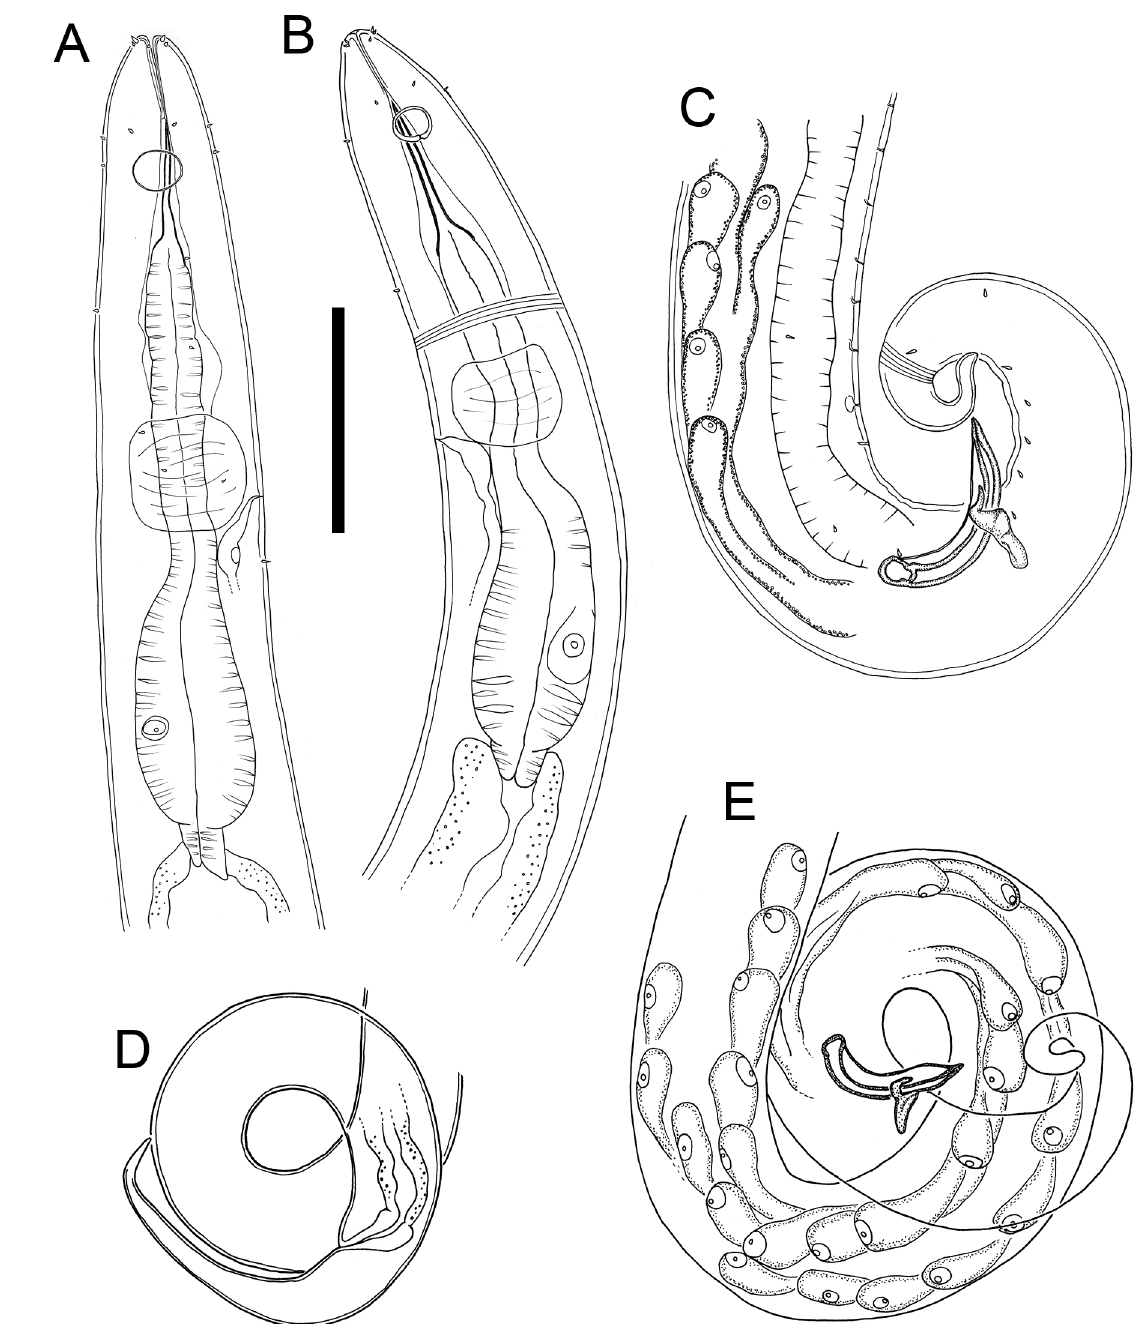
Fig. 1. Siphonolaimus curtisensillus sp. nov. A , C . Holotype (NIWA154903). B , D , Paratype (NIWA 154904). E . Paratype (NIWA154905). A . Male anterior body region. B . Female anterior body region. C . Male posterior body region. D . Female posterior body region. E . Male posterior body region. Scale bar: A–B = 75 µm; C = 70 µm; D = 85 µm; E = 125